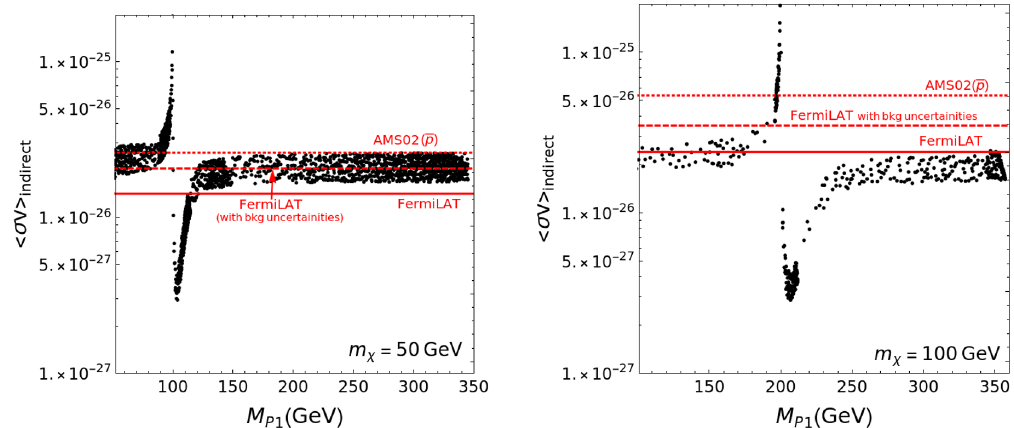
Figure 2 . The behaviour of the indirect detection cross section as a function of the mass of the lightest pseudoscalar M . We consider a fixed heavier mediator mass m = 500 GeV and dark P 1 P 2 matter masses of m = 50 GeV (left panel) and m = 100 GeV (right panel). In this plot, the χ χ couplings of the pseudoscalar with the SM fermions are varied while the couplings to dark matter is fixed to y = 1 . The constraints from FermiLAT and AMS-02 (anti-protons) are also shown as χ dashed lines. The regions below the dashed lines are allowed at 95%